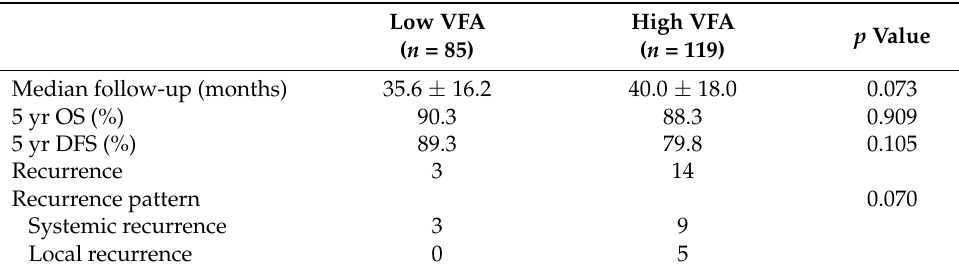
Table 5. Oncologic Outcomes.